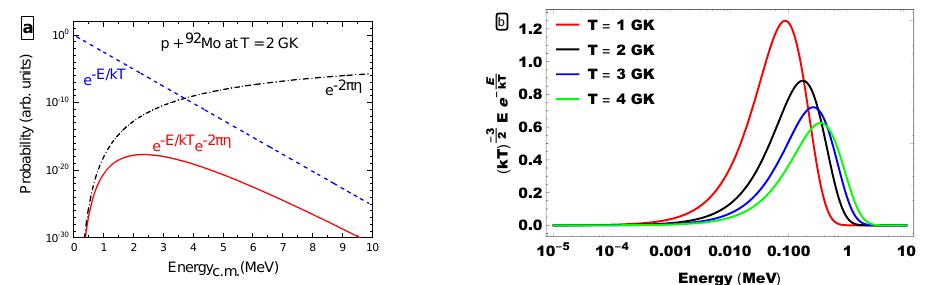
Figure 2. (Color Online) (a) Gamow window for p + 92 Mo at T = 2 GK and (b) Reaction rate equation parameters behaviour at di ff erent